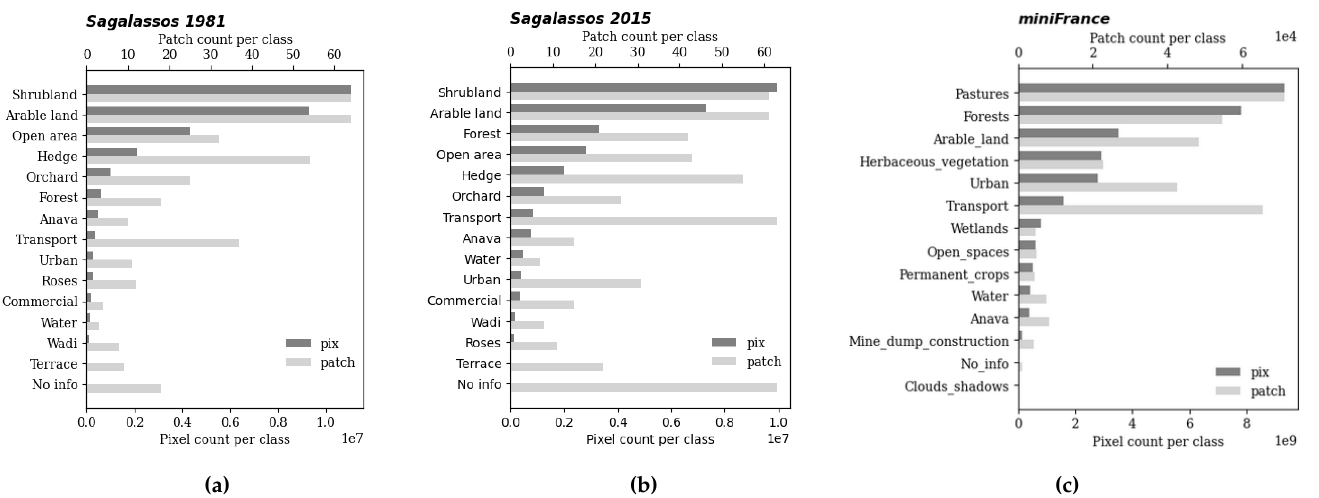
Figure 3. Distribution of both the pixel and patch count over the different land cover classes for ( a ) the Sagalassos 2015, ( b ) the Sagalassos 1981 and ( c ) the MiniFrance annotation data. In total, the MF-labelled subset consists of 409 RGB orthophotos (8-bit JPEG 2000 compressed tif format) of dimensions 10, 000 × 10, 000 px² and 0.5 m GSD, corresponding to an aerial coverage of roughly 10,225 km². The imagery covers both urban and rural scenes over the counties Nice and Nantes/Saint Nazaire between 2012 and 2014. The land cover labels are provided as rasterized Urban Atlas tiles with equal size and resolution as the orthophotos. Each pixel is integer encoded as one of the 13 occurring classes: urban fabric, transport units, mine/dump/construction, artificial non-agricultural vegetated areas, arable land (annual crops), permanent crops, pastures, forests, herbaceous vegetation associations, open spaces with little or no vegetation, wetlands, water, clouds and shadows. The annotations have a minimum mapping unit (MMU) of 0.25 ha in urban area and 1 ha in rural area [78]. Examples can be found in Supplementary Figure